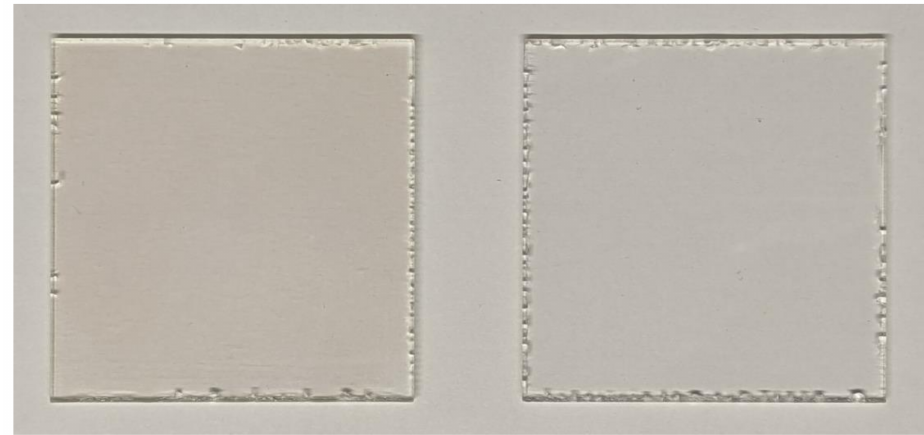
Figure 4. Photographs of samples with ZnO coating ( left ) and without it ( right